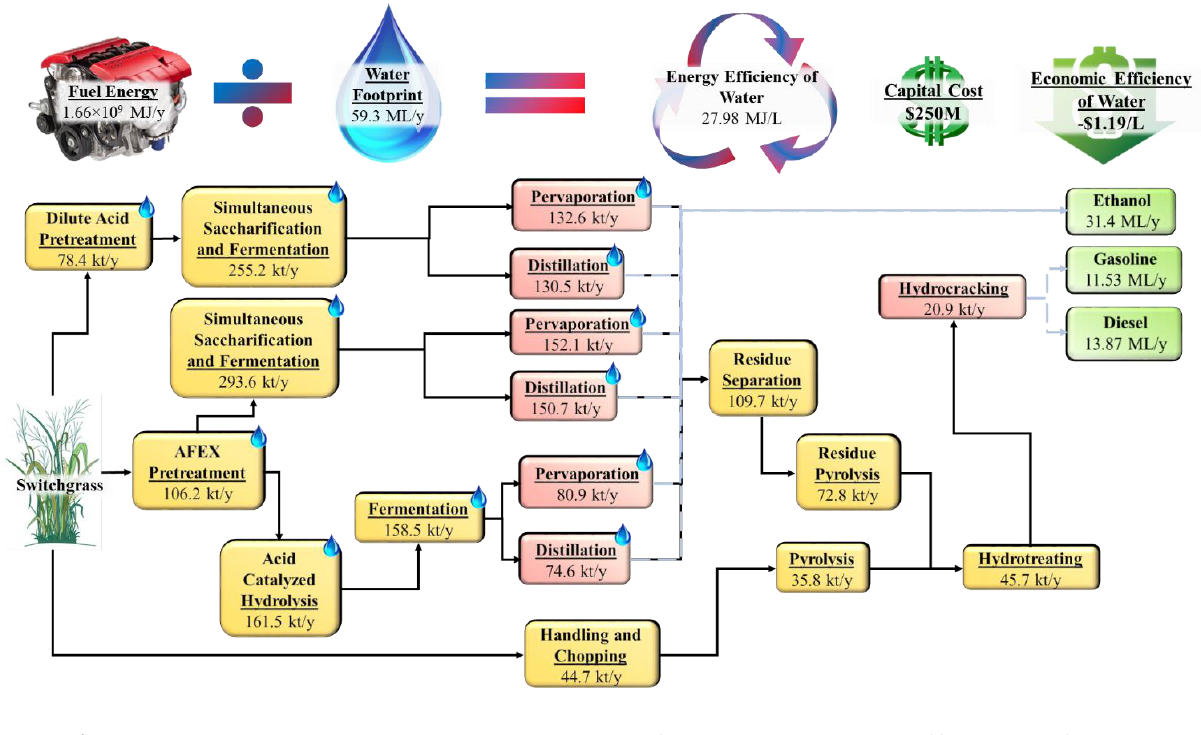
Figure 6. Optimal processing pathway, water footprint, economic efficiency of water, overall capital cost, and energy efficiency of water of the maximum energy efficiency of water